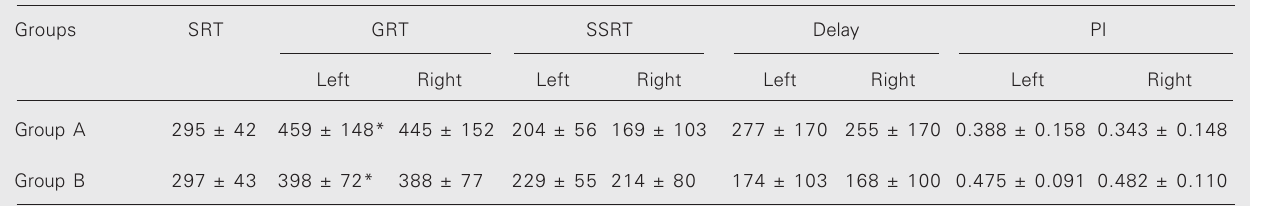
Data are reported as means ± SEM (N = 17 in each group). SRT = mean of medians of left and right simple reaction time; GRT = go-signal reaction time; SSRT = stop-signal reaction time; Delay = interval between go- and stop-signal; PI = probability of responding to a stop-signal; Left = left visual field; Right = right visual field. Note that the delay presented within the right hemifield is the delay of the stop-signal presented on the contralateral side, and vice-versa. Group B performed the task with the on-line control of the stability of go-signal reaction times. *P < 0.05 compared to right GRT